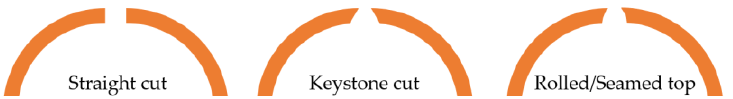
Figure 1. Slotted liner slot configuration [by authors].